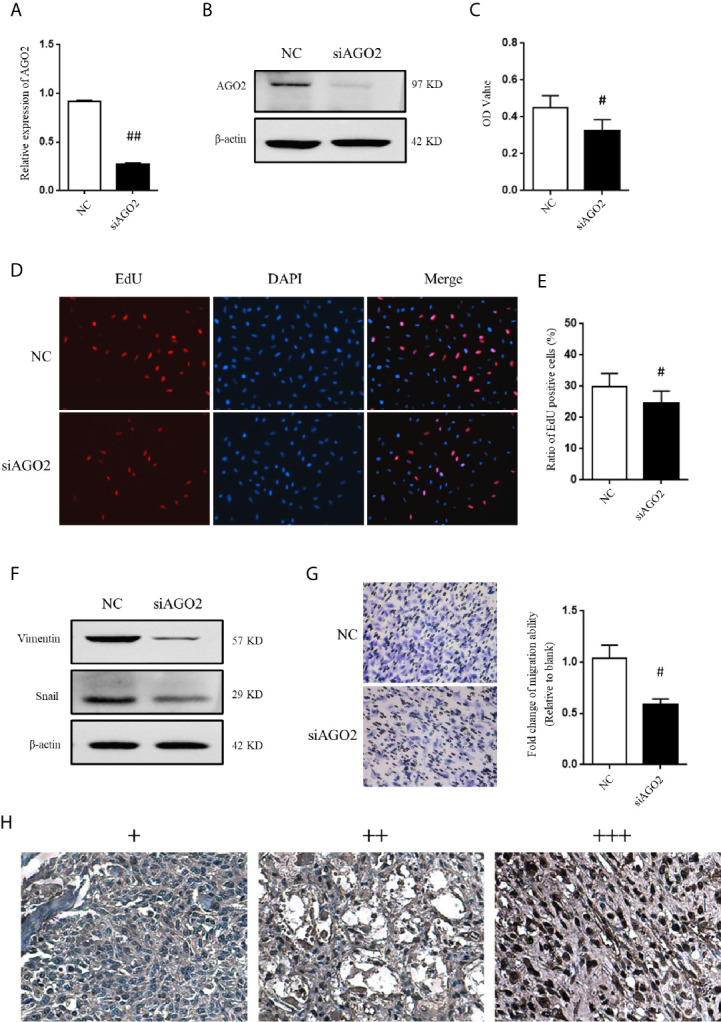
AGO2 regulates OS cell progression and migration. (A) qPCR and (B) western blotting analysis were performed to detect the efficiency of AGO2 siRNA. ## indicates P < 0.01 compared to the NC group. (C) SJSA-1 cells with NC siRNA or AGO2 siRNA transfection were subjected to a CCK-8 assay to examine cell viability. # indicates P < 0.05 compared to the NC group. (D) EdU proliferation assay analysis was performed 48 h after AGO2 siRNA or NC siRNA transfection in SJSA-1 cells. Cell nucleus was stained with DAPI. Original magnification 200x. (E) Statistical graph of EdU assay. # indicates P < 0.05 compared to the NC group. (F) Representative images of western blotting for EMT markers vimentin and transcriptional factor Snail. β-actin served as an internal loading control. (G) Representative images of transwell migration assay of SJSA-1 cells with AGO2 knockdown and NC siRNA control. Statistical graph of transwell migration assay is shown. # indicates P < 0.05 compared to the NC group. Representative images from three separate experiments are shown. (H) Expression of AGO2 protein in OS tissues from patients with osteosarcoma. Representative images of different IHC staining intensities of AGO2 are shown in OS tissues. Staining patterns were categorized into three groups as follows: weak staining (+), moderate staining (++), and intense staining (+++). Original magnification 200x.